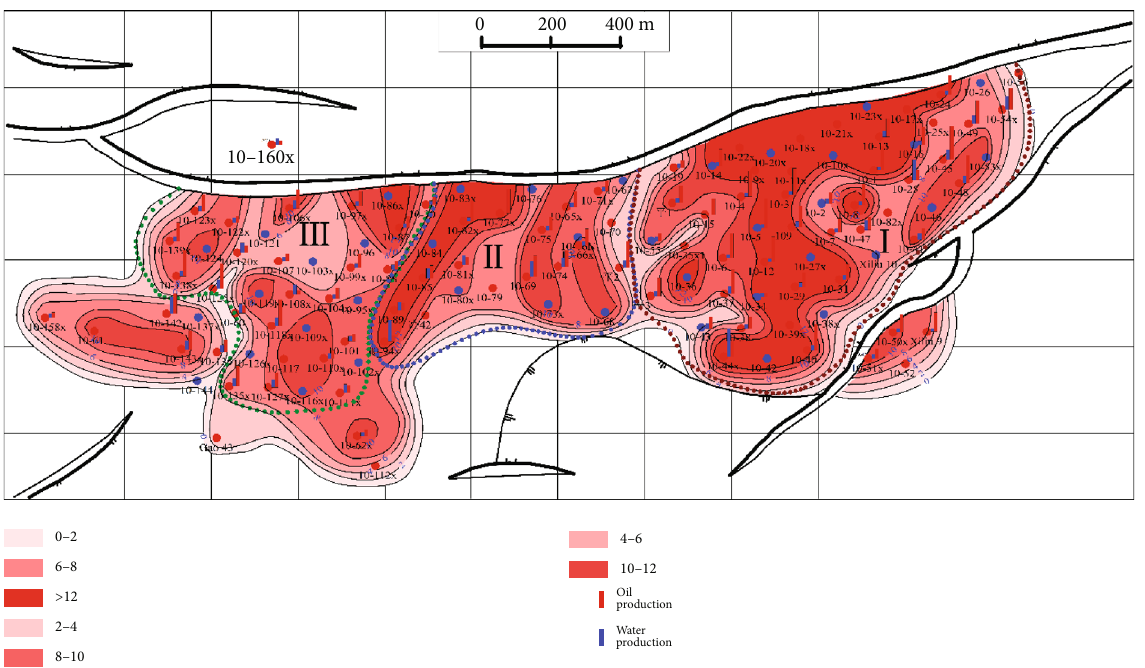
Figure 5: Overlapping map of the e ff ective thickness and production dynamics of the Es